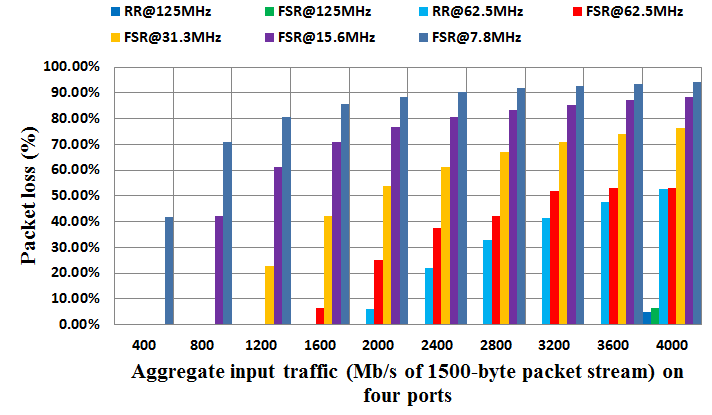
Figure 13. Packet loss of the RR and the FSR under different frequencies and traffic bit